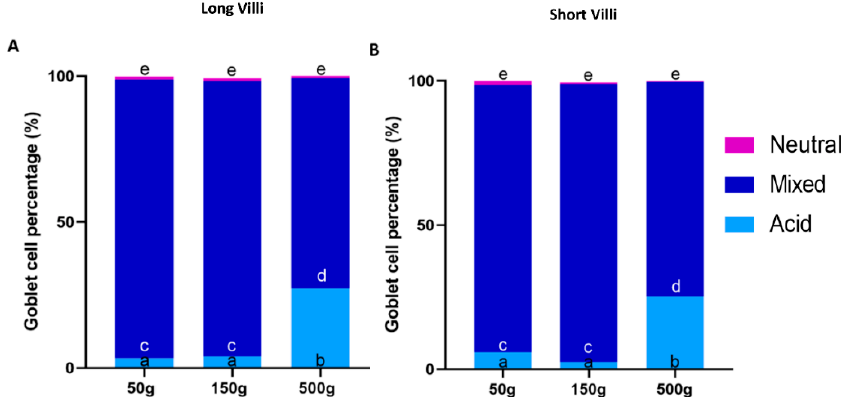
Figure 11. Estimation of the percentage of goblet cells secreting acid mucins (AB positive), mixed mucins (AB/PAS positive) and neutral mucins (PAS positive) in the proximal intestine of both short ( A ) and long ( B ) villi along rainbow trout development. a–e Different superscripts within the same histogram indicate significant di ff erences ( p < 0.05) measured by one-way ANOVA (animal weight: independent